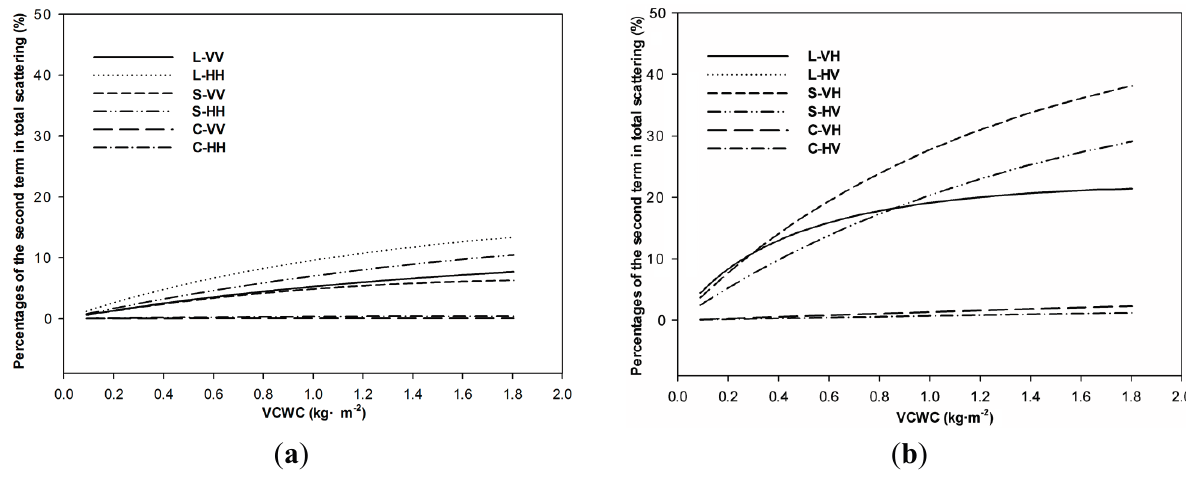
Figure 2. Percentage of the second term scattering with different bands and different polarization in total scattering (L, S, C represent the different bands, and VV, HH, VH, and HV represent the different polarizations). ( a ) Co-polarization (Plots from top to bottom are L-HH, S-HH, L-VV, S-VV, C-HH, C-VV); ( b ) Cross-polarization (Plots from top to bottom are S-VH, S-HV, (L-VH, L-HV), C-VH,